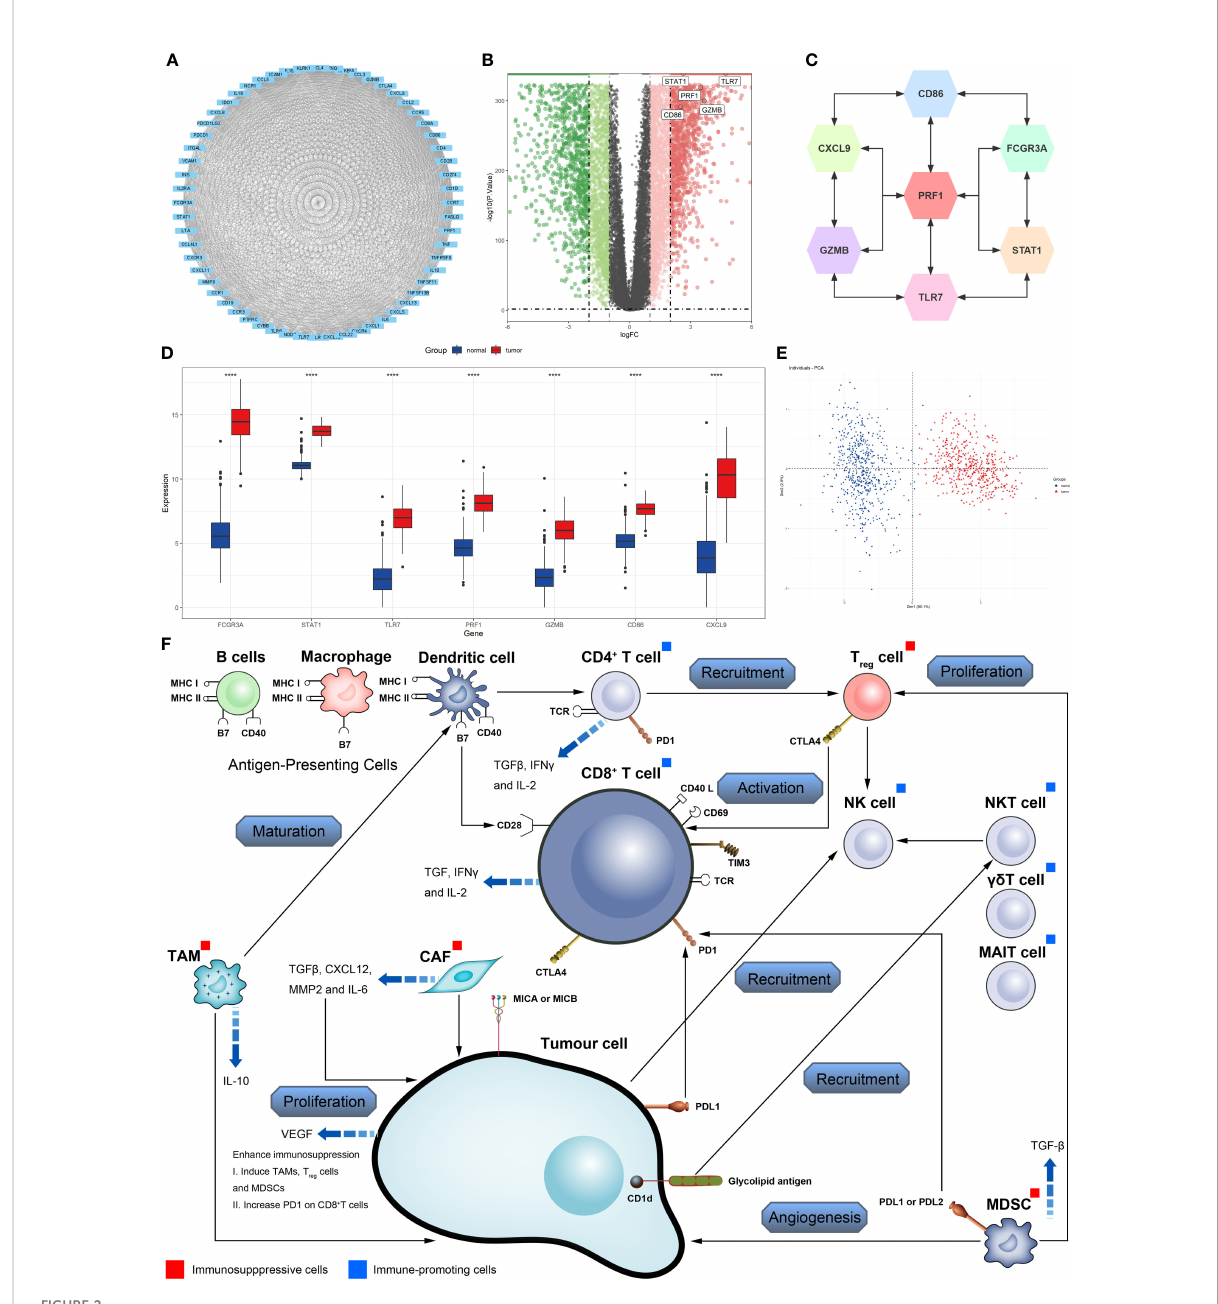
FIGURE 2 Identi fi cation of key molecules in cutaneous melanoma. (A) Construction of protein-protein interaction (PPI) network among differentially expressed genes. (B) Volcano plot constructed with the cut-off criterion P <0.05 and |logFC| ≥ 1. (C) The relationship among the seven key molecules at the protein level, each gene is closely linked to each other at the protein level. (D) The seven key molecules expressed in the normal skin and cutaneous melanoma (**** P < 0.0001). (E) Principal component analysis for the key molecules revealed. This result shows that seven key molecules can distinguish very well between normal skin and cutaneous melanoma. (F) Effect of immune and stromal cells on cutaneous